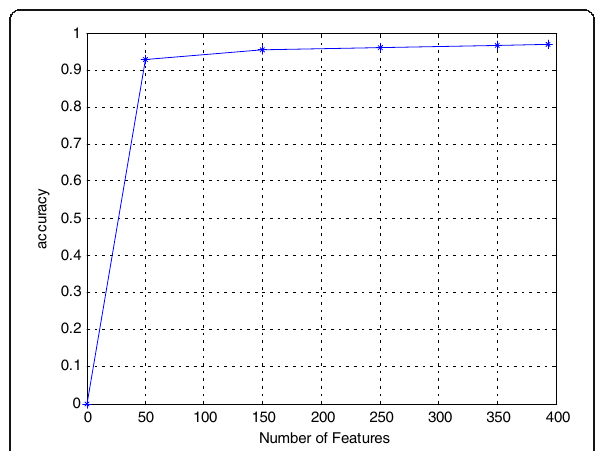
Fig. 4 Recognition rates with different number of color features